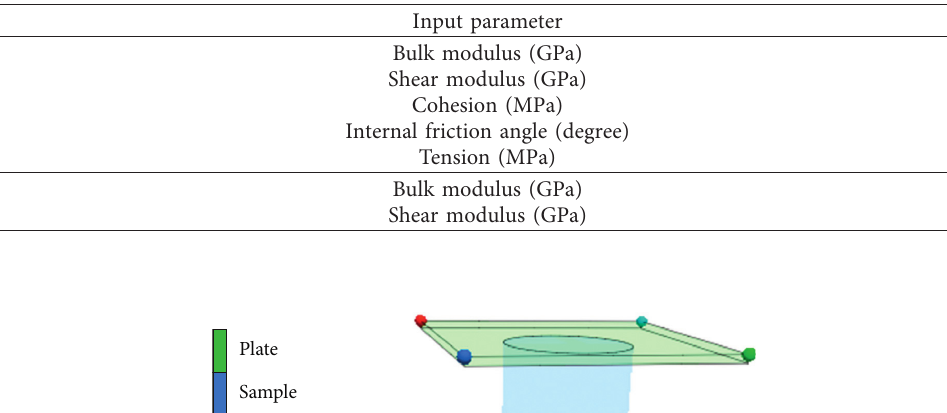
Figure 1: Geometry of the UCS test created in numerical simulation. Table 1: Input parameters for the sample and the plate.